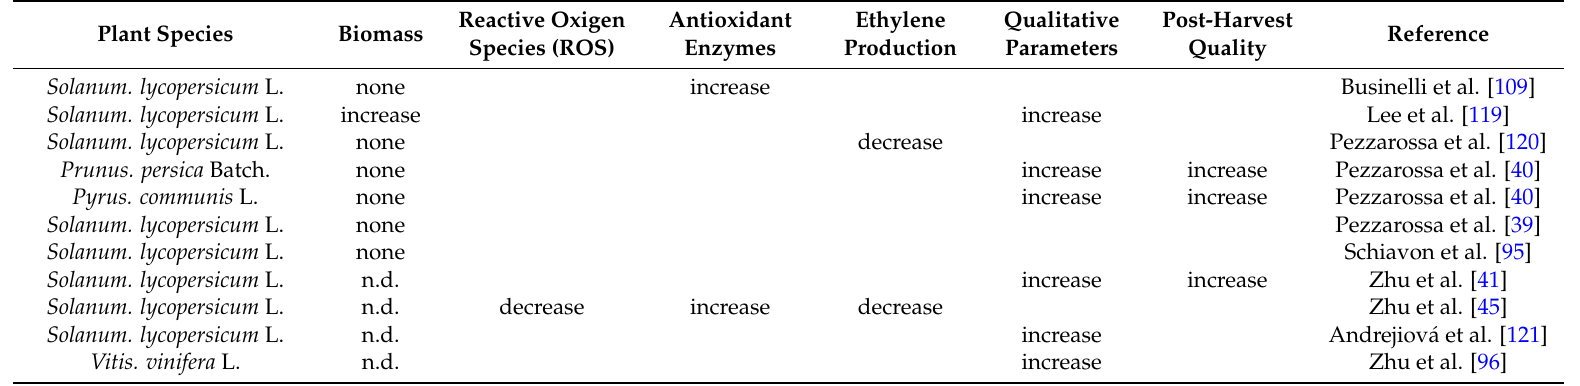
Table 4. Main effects of selenium (Se) treatments on fruit